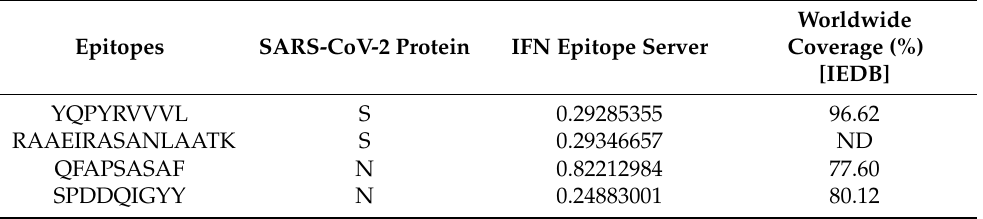
Table 10. Promising peptides predicted to induce the release of TNF gamma showing the worldwide estimated coverage calculated by IEDB. ND: no data available.